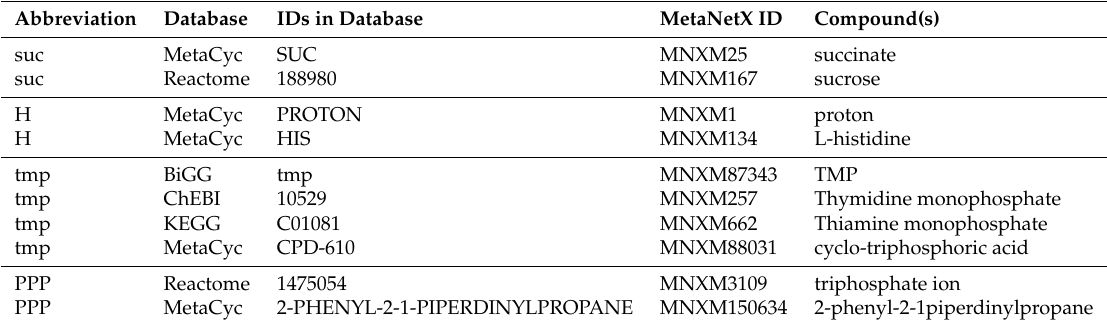
Table 9. Examples of mapping